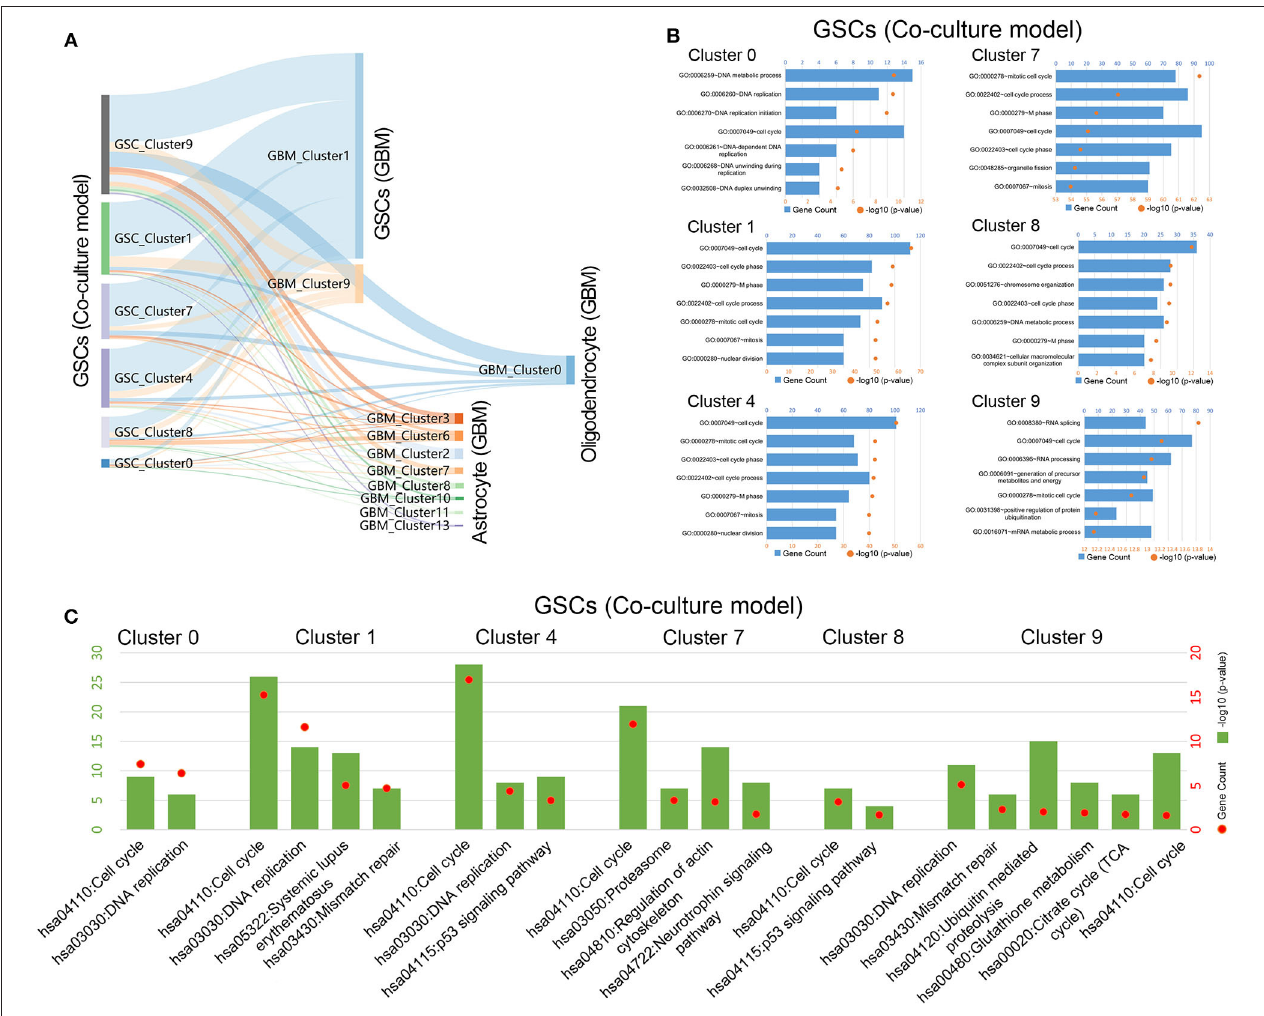
FIGURE 3 | Gene function analysis of glioma stem cells in the coculture model. (A) Gene numbers simultaneously expressed in glioma stem cells in both the coculture model and surgical specimens. (B) Enrichment analysis of biological functions for glioma stem cells in the coculture model. (C) Path enrichment analysis for glioma stem cells in the coculture